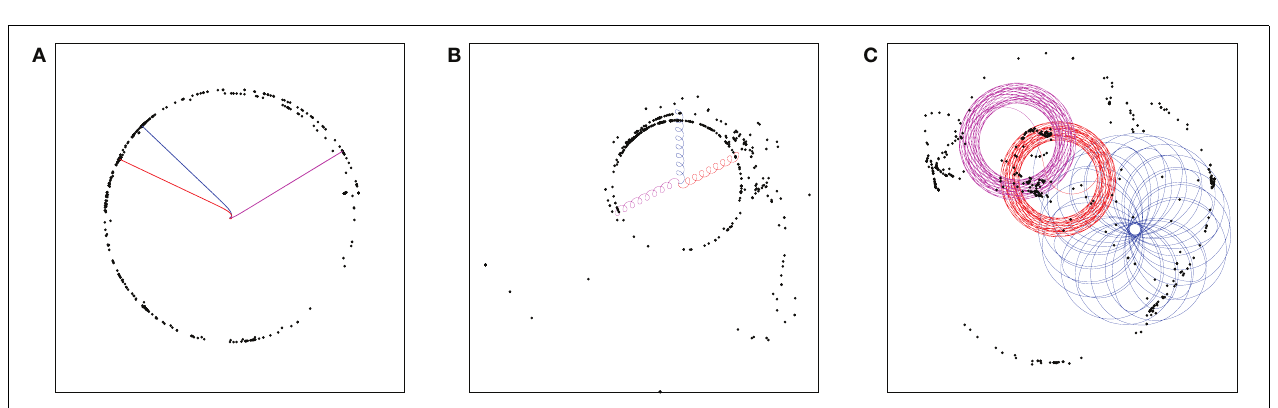
of SSS has been plotted against n . (B) The fraction g CS ( N , n ) of CS has been plotted against n . (C) The sum g SSS ( N , n ) + g CS ( N , n ) has been plotted and it is seen that beyond n ≈ 8 the sum is approximately unity.